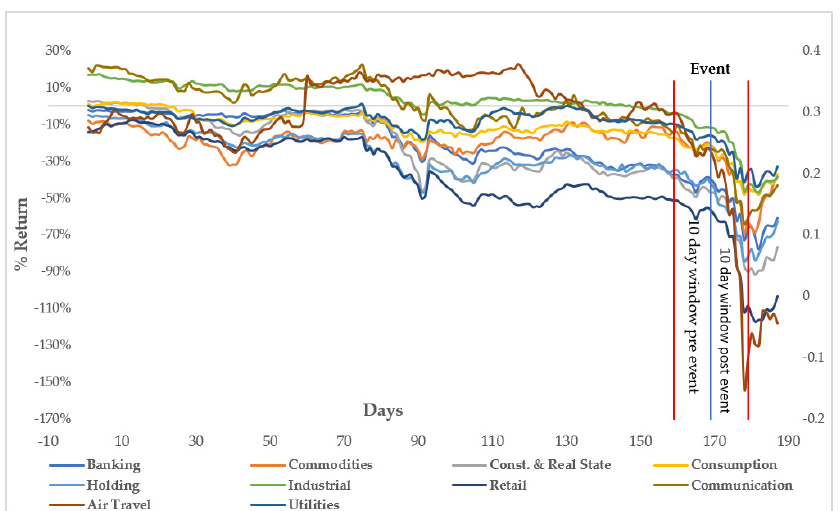
Figure 3. Cumulative returns by industry for 10 day windows before and after event. Taken from assets belonging to the IPSA. Source: Authors’ own elaboration.